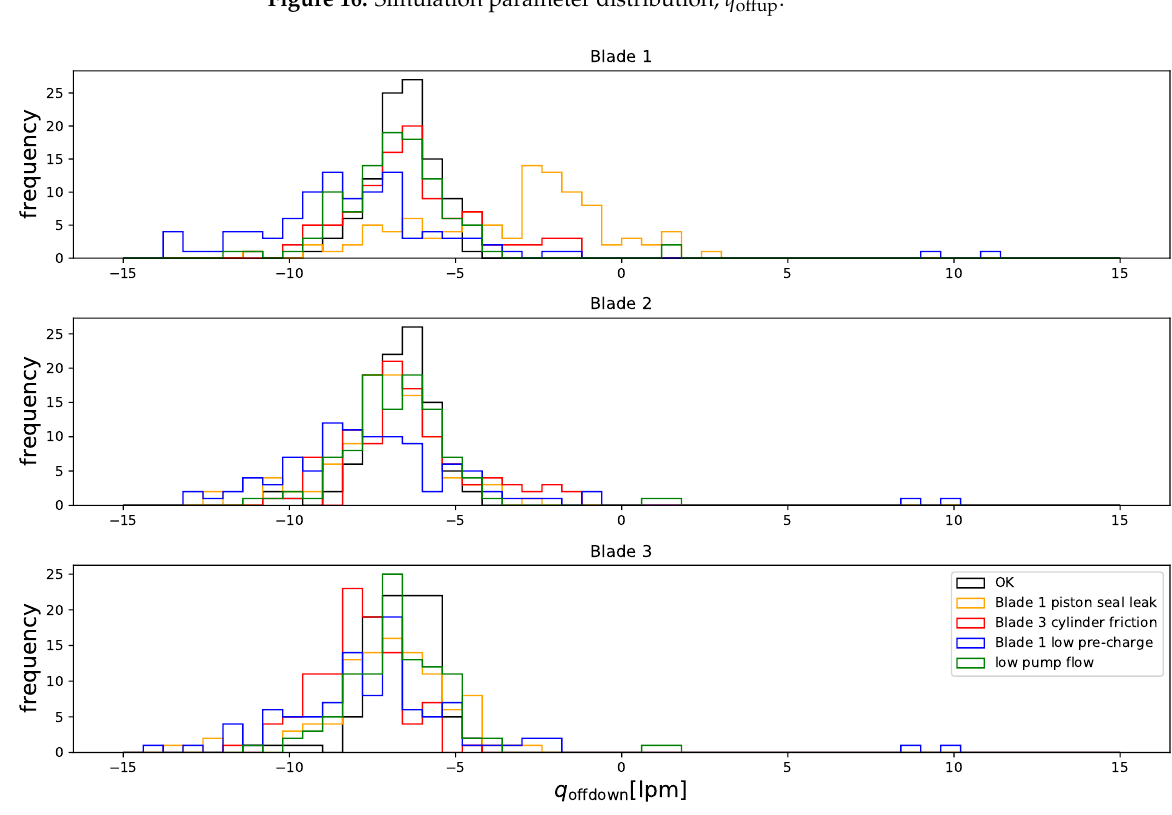
Figure 16. Simulation parameter distribution, q offup .